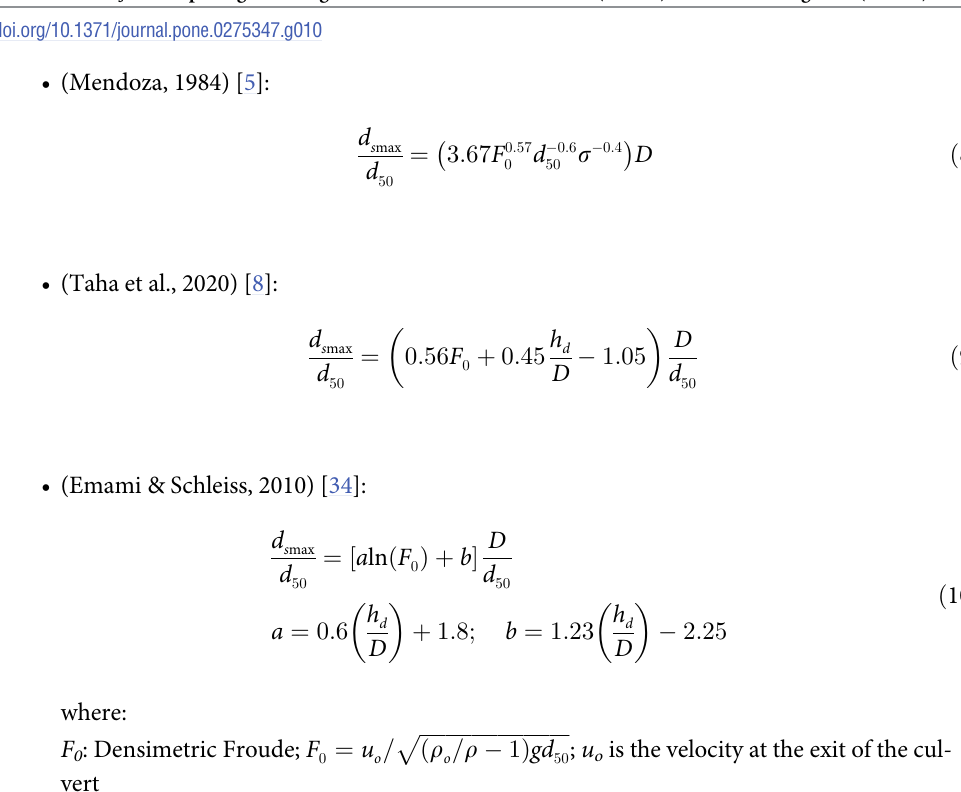
and maximum scour depth ratio ( d s